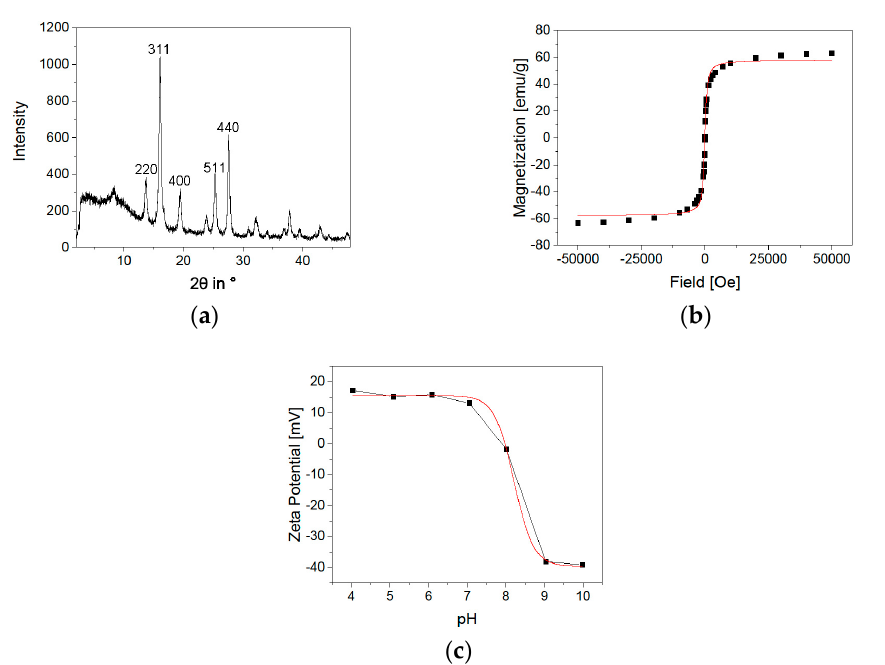
Figure 3. ( a ) XRD measurement of BIONs, ( b ) SQUID analysis of BIONs at 300 K with LangevinMod fit and ( c ) Zeta potential of BIONs at pH values from 4 to 10 with a Boltzmann fit.